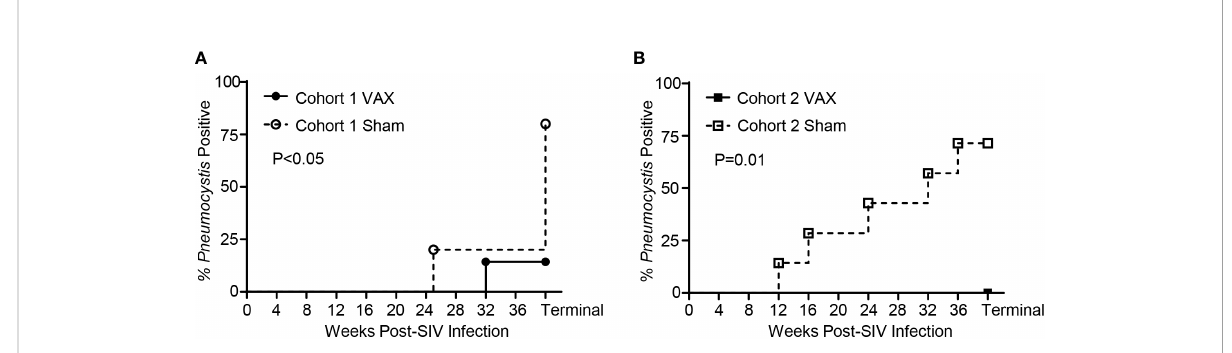
FIGURE 6 Pneumocystis co-infection throughout SIV-infection in vaccinated and sham vaccinated rhesus macaques. (A) Incidence of Pneumocystis co- infected rhesus macaques in Cohort 1. A diagnosis of Pneumocystis co-infection was made through detection of Pneumocystis DNA by polymerase chain reaction ( fi rst-round PCR) analysis of bronchoalveolar lavage fl uid (BAL) or terminal lung homogenate, or by immunohistochemistry staining of FFPE lung sections with anti- Pneumocystis antibody 3FC. (B) Incidence of Pneumocystis co-infection in Cohort 2 was diagnosed through fi rst-round PCR analysis of BAL fl uid. Signi fi cance was determined by Mantel-Cox